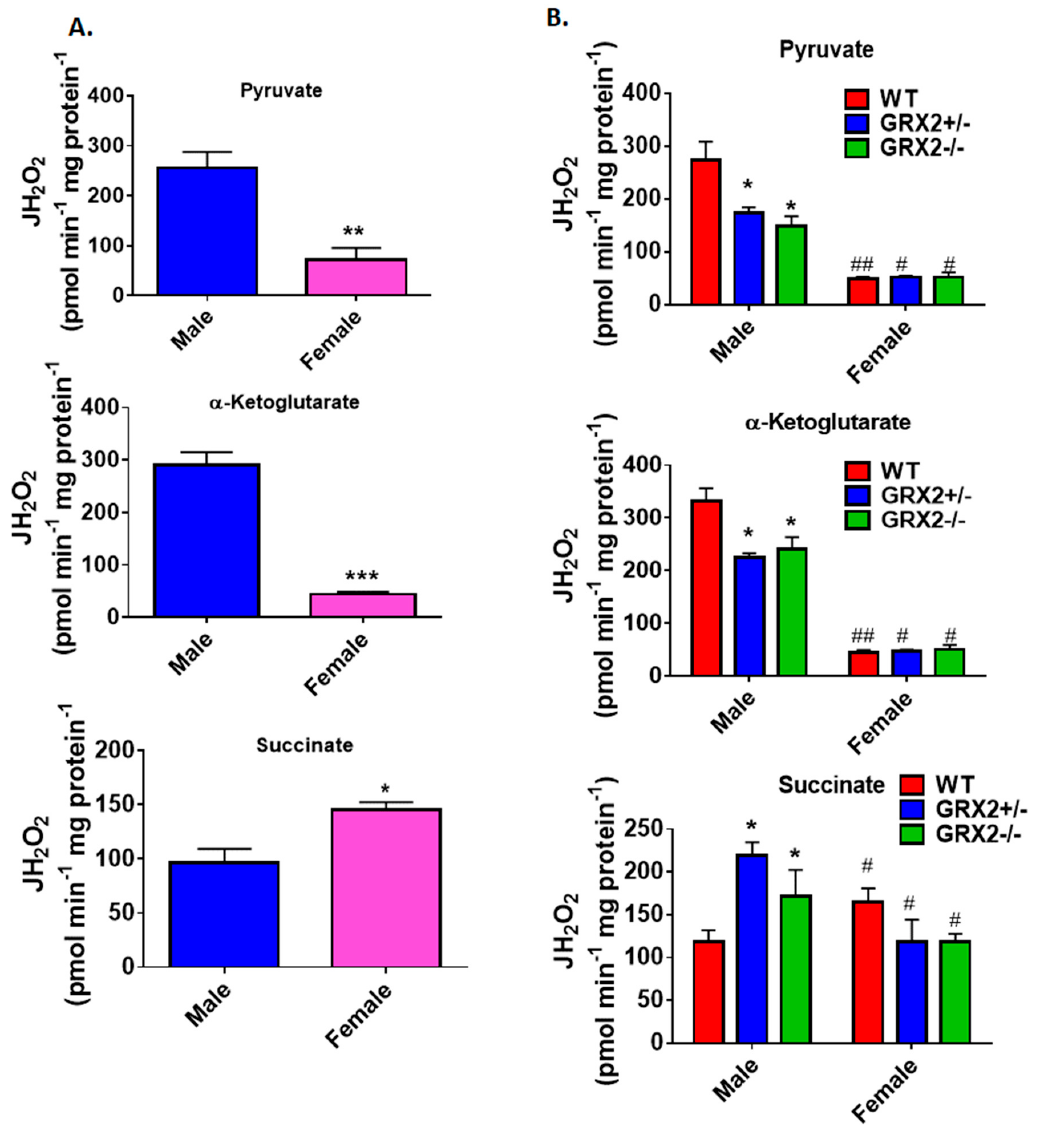
Figure 2. Examination of the sex differences associated with H 2 O 2 production by liver mitochondria isolated from female and male littermates deficient for GRX2. ( A ). Comparison of the rate of H 2 O 2 production by liver mitochondria isolated from male and female WT littermates and energized with 50 µM pyruvate, α -ketoglutarate, or succinate. n = 4, mean ± SEM, two-tailed Student’s T -Test. ( B ). Impact of GRX2 deficiency on rates of ROS production by liver mitochondria from male and female mice. n = 4, mean ± SEM, 2-way ANOVA with a post-hoc Tukey’s test, * represents a genotype comparison within a group and # represents a sex comparison. * or #: p ≤ 0.05, ** or ##: p ≤ 0.01, *** or ###: p ≤ 0.001.